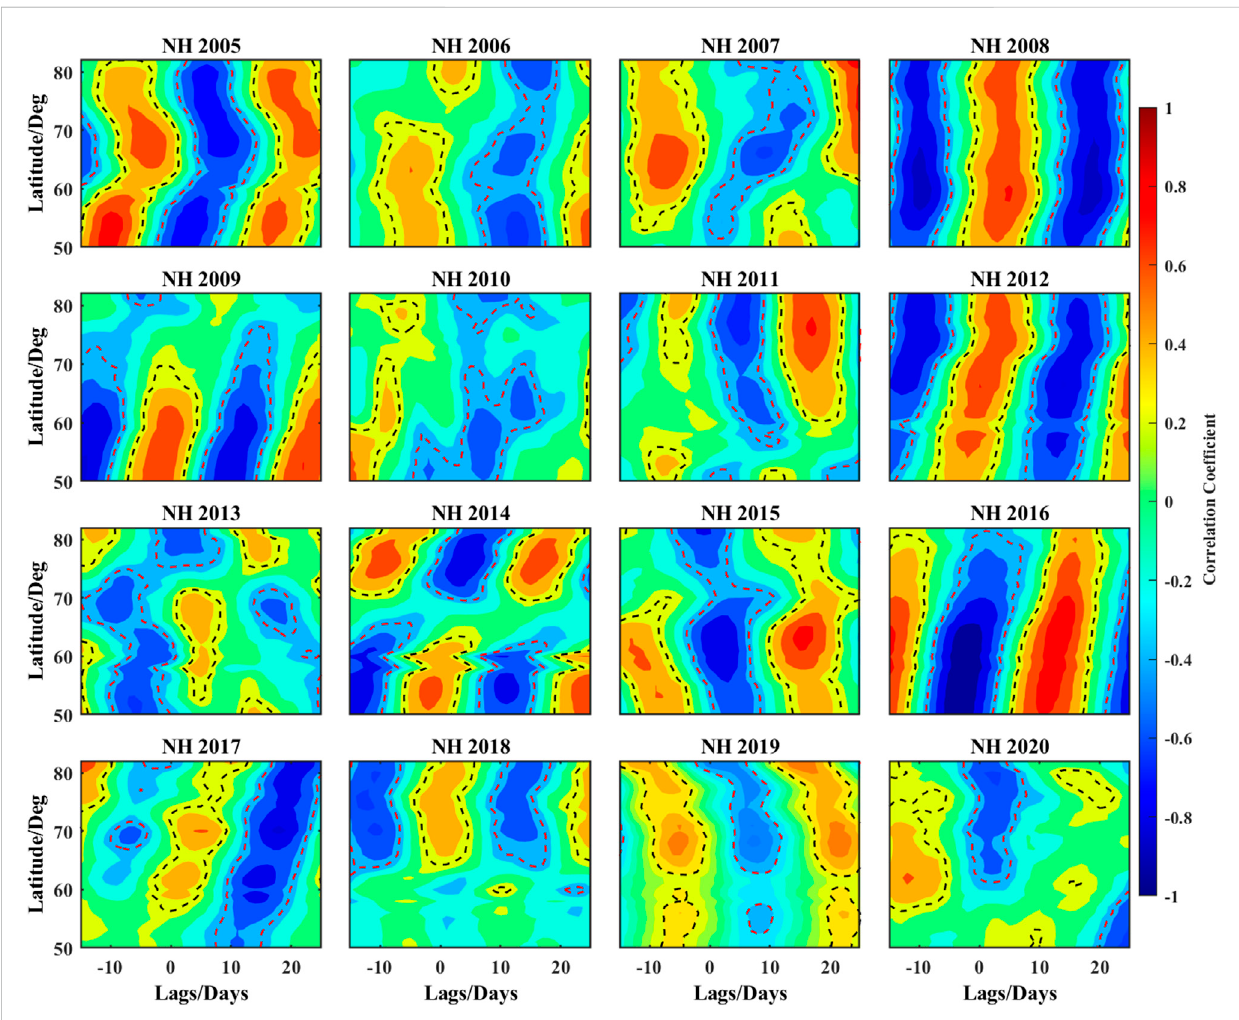
Correlation between the temperature and Y10 anomalies at 0.46 Pa over different latitudes, for the NH PMCs seasons during 2005 – 2020. The temperature data from MLS is averaged in the corresponding latitude. The red area surrounded by black dashed lines indicates that the signi fi cance level of the positive correlation between temperature and Y10 is greater than 95%. The blue area surrounded by the red dotted line indicates that the signi fi cance level of the negative correlation between temperature and Y10 is greater than